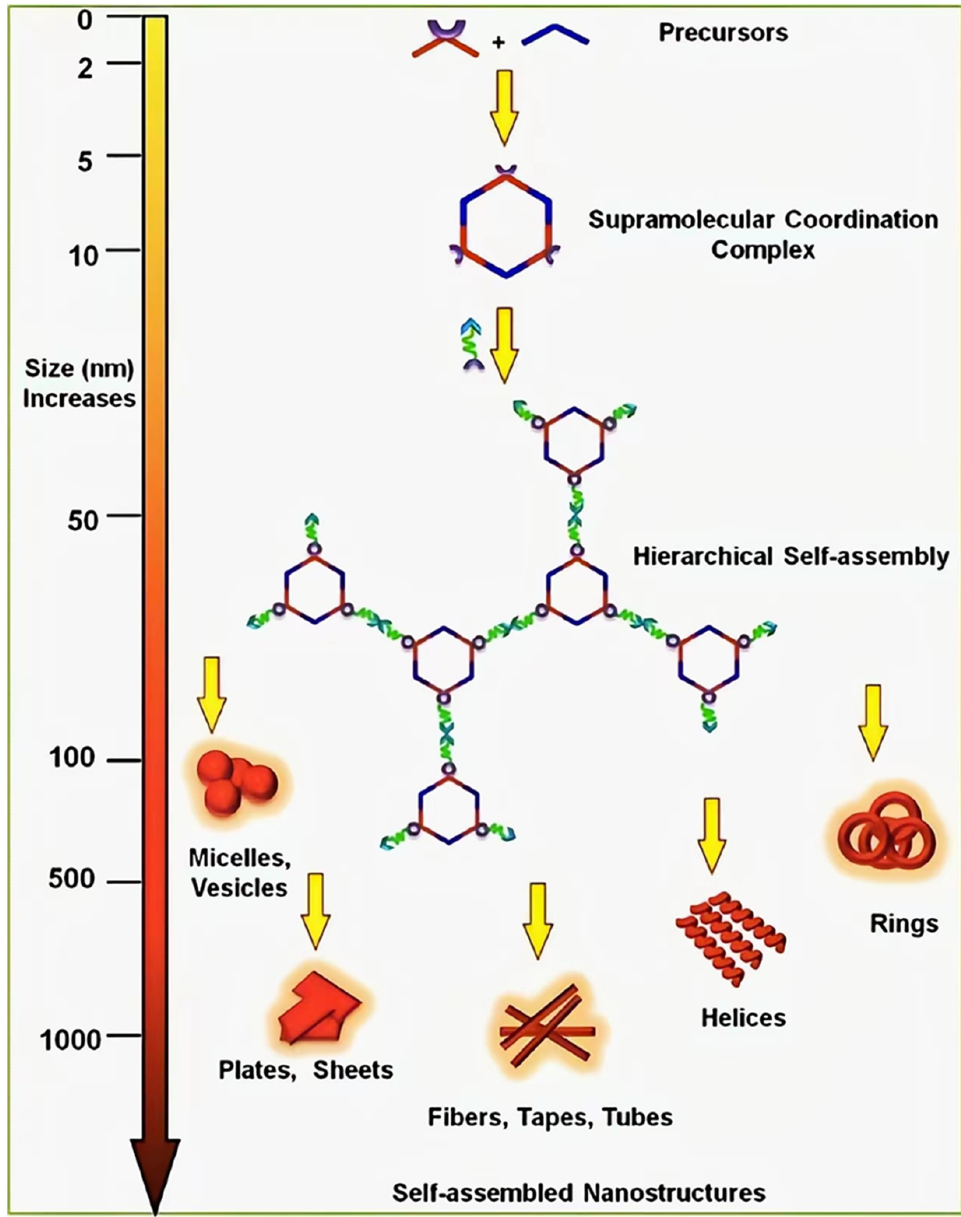
Figure 35. Schematic representation of hexagonal SCC prepared through coordination-driven self- assembly with suitable precursors and well-defined nanostructures of HSA assembled by it using multiple orthogonal interactions (reproduced with permission of American Chemical Society from ref. [108]).